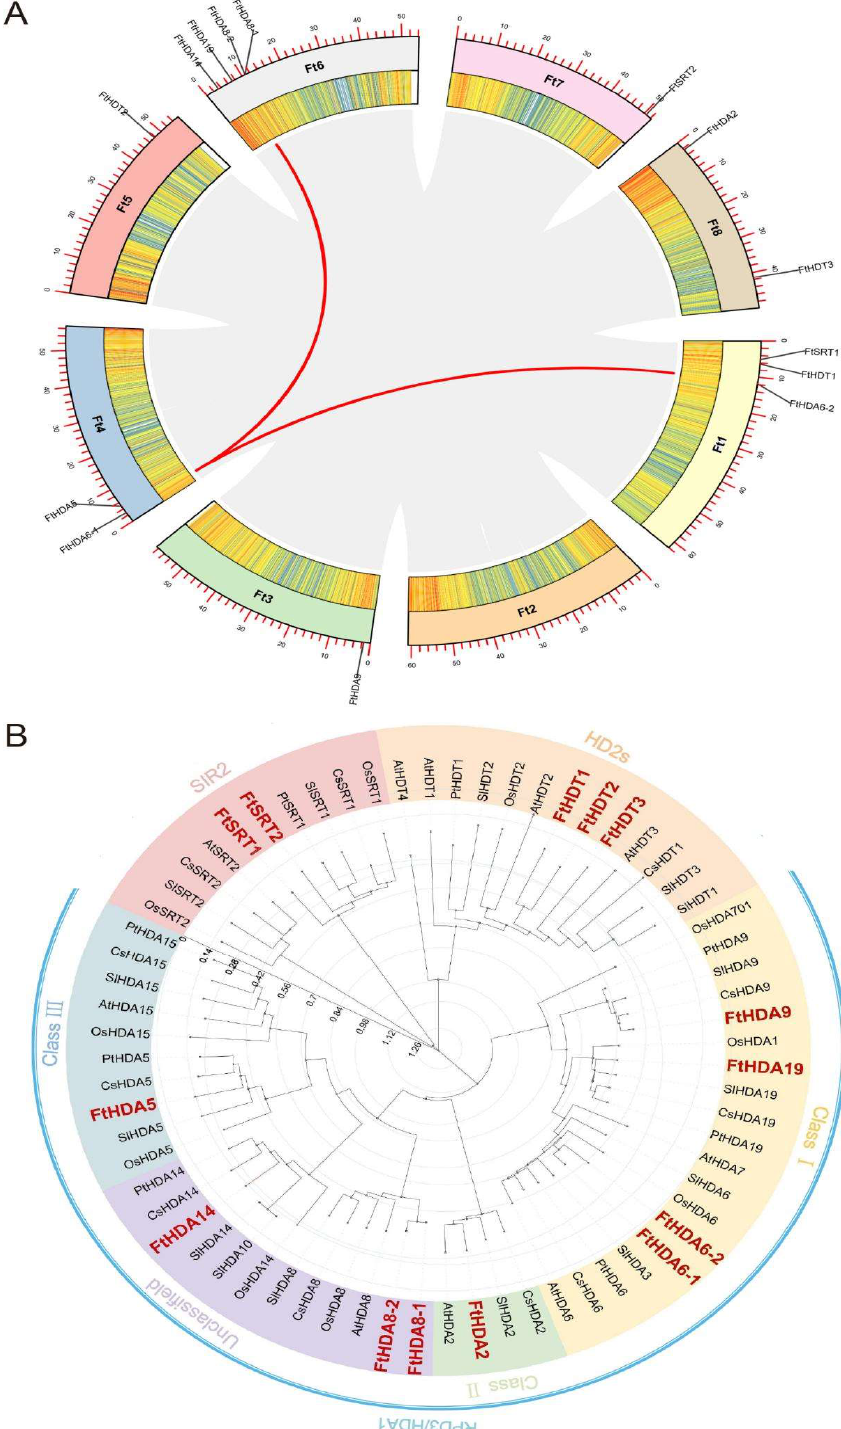
Figure 3. Chromosomal localization and Phylogenetic analysis of FtHDA6 . ( A ) Distribution of FtHDACs gene on Fagopyrum tataricum chromosomes, intraspecies collinearity and gene density. ( B ) Phylogenetic tree construction of HDACs gene family from Fagopyrum tataricum (Ft) , Arabidopsis (At) , Solanum lycopersicum (SI), Oryza sativa (Os), Populus trichocarpa (Pt), Citrus sinensis (Cs). Each subgroup ID number is in the outer circle of the phylogenetic tree and branches with less than 70% bootstrap support are collapsed (replicated 1000 times). The different filling colors indicate different gene subfamilies, and the length of the clade indicates the evolutionary distance.